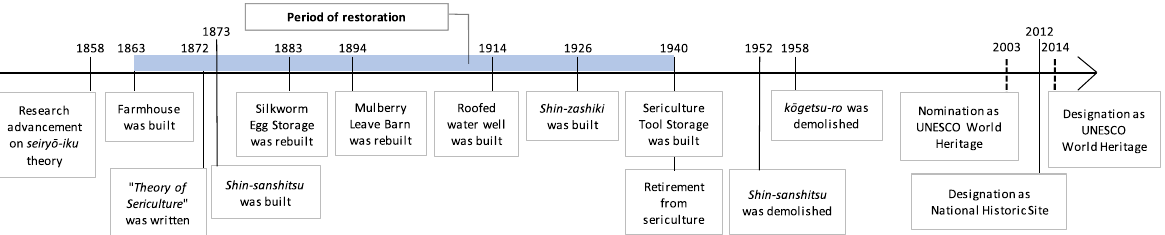
Fig. 11 Event timeline of the Tajima Yahei Sericulture Farm and its period of restoration. (Source: Cheng